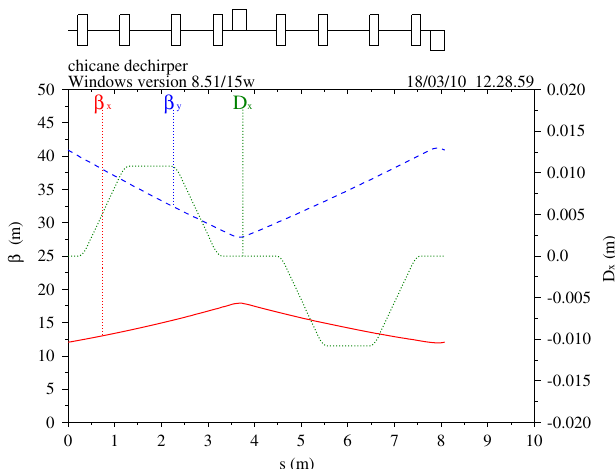
FIG. 4. Lattice functions for a dechirping cell that contains two chicanes.